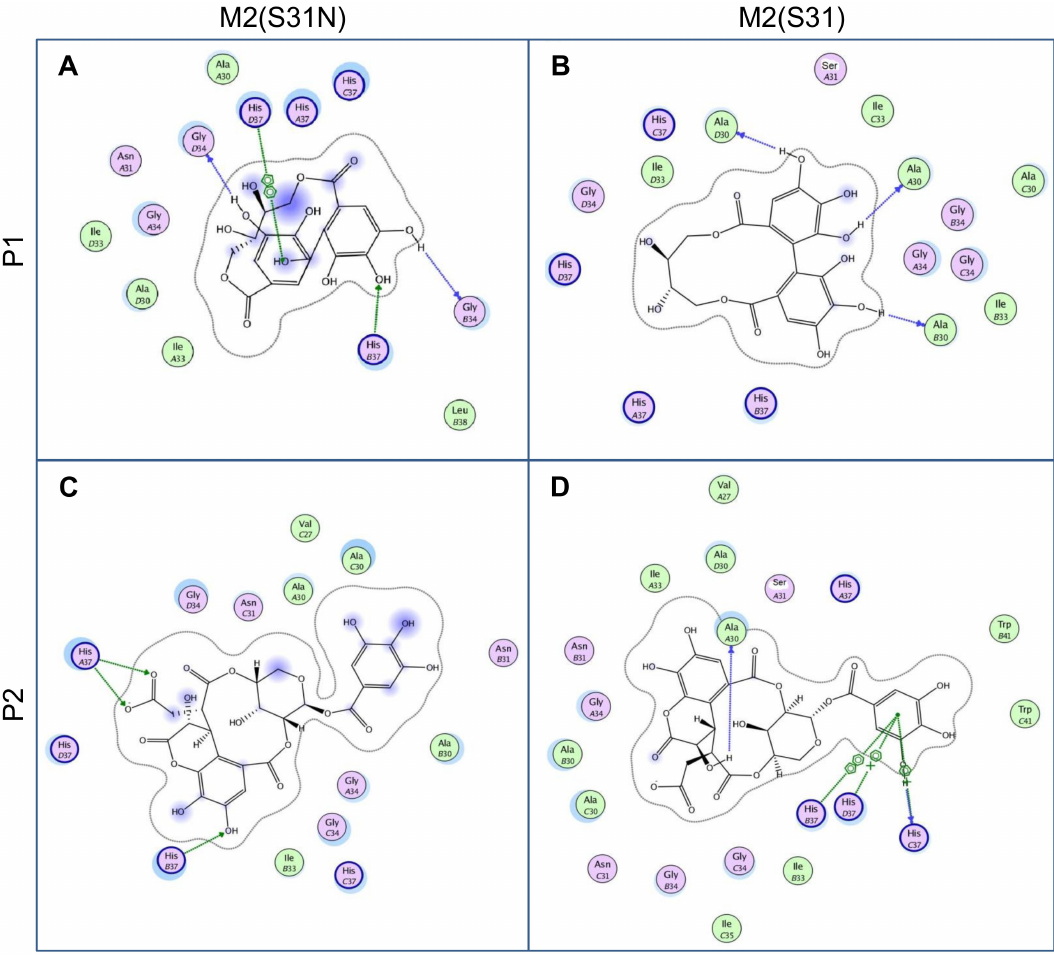
Figure 5. Relative 2D protein-ligand interaction maps of P1 and P2 into M2(S31N) and M2(S31). For each panel, the proposed ligand-protein interactions, amino acids and M2 subunit ( A − D ) are described as follows; green arrows are H-bond acceptors, blue arrows are H-bond donors, and green lines are π - π and cation- π